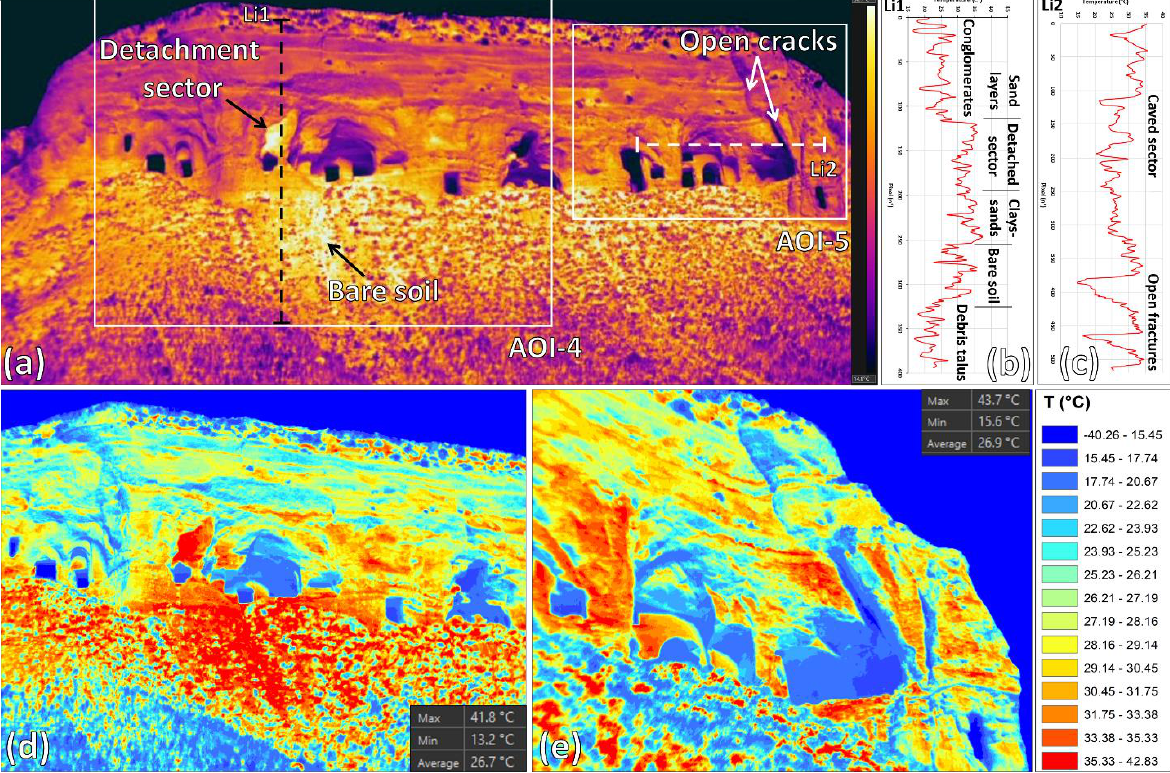
Figure 13. Sabereebi IRT data: Mosaicked surface temperature map (950 × 480 pixels with 6.5 cm resolution ( a ); vertical and horizontal surface temperature profiles Li1 ( b ) and Li2 ( c ). Classified surface temperature maps in correspondence of AOI 4 ( d ) and AOI 5 ( e ).